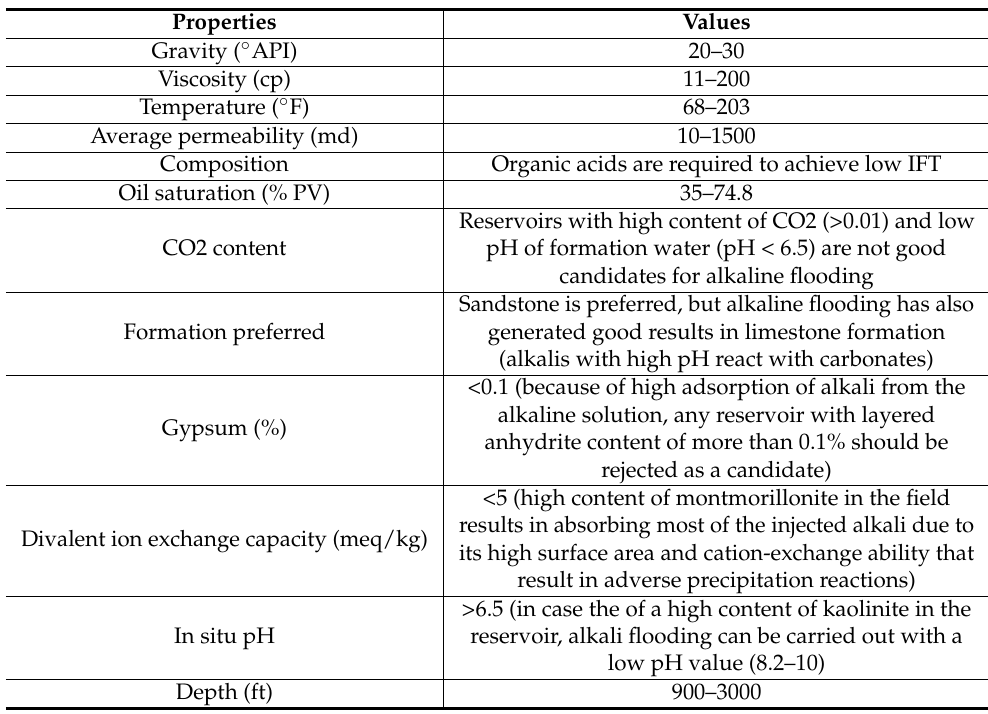
Table 2. Screening criteria for alkaline